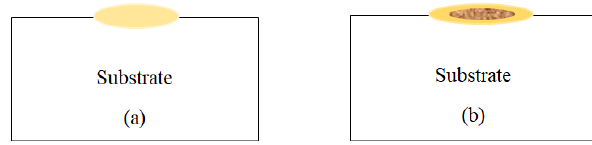
Figure 9: Schematic illustration of melting states during plasma spraying (a) melted powder and (b) partially melted